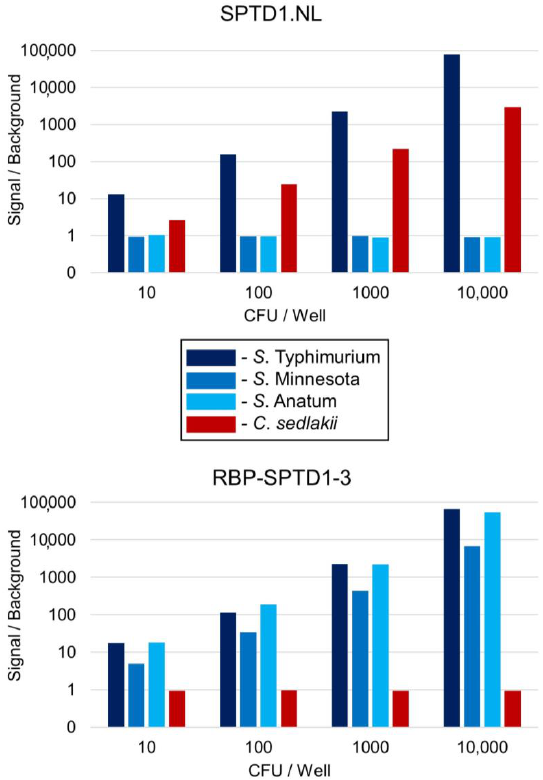
Figure 5. Compared to SPTD1.NL, RBP-SPTD1-3 has superior performance as a Salmonella diagnostic phage. Wells were prepared with log-phase cultures of each bacterial strain diluted to the indicated burden. Infection was initiated by adding 10 µL of a working stock (1.2 × 10 7 PFU per mL) of SPTD1.NL (Top) or RBP-SPTD1-3 (Bottom) to each well. After two hours, Nanoluc ® production was assessed using a GloMax ® Navigator. Relative light units (RLU) values were obtained and averaged for replicate wells to determine signal. Background was calculated as the average RLU of replicate wells without bacteria (TSB only). As per the legend, Salmonella serovars are indicated by shades of blue, whereas C. sedlakii is in red. Bacterial strain information is provided separately (Table S1). The S . Anatum strain used was SLR 377. Individual RLU values for each well are provided separately (Table S2).